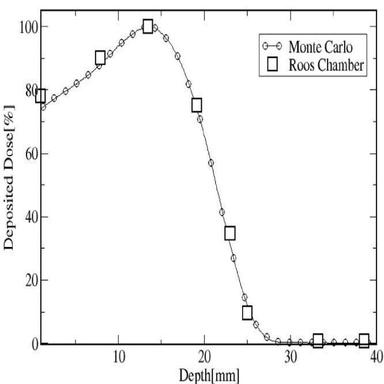
PDD curves measured (6 MeV electrons) and Monte Carlo (6.3 MeV electrons) in Bolus CM.